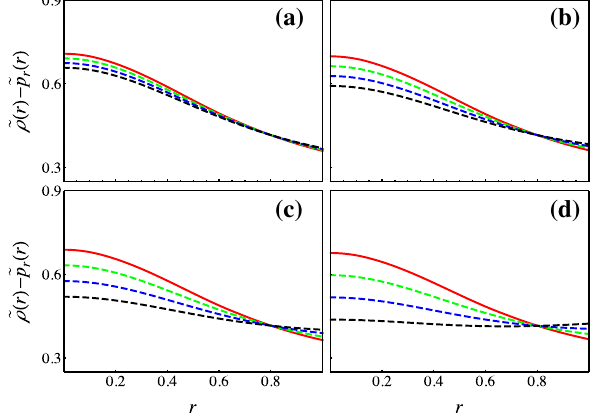
Fig. 3 Effective tangential pressure ˜ p t for M = 0 . 2, R = 1, c 1 = 0 . 5 and a C = − 0 . 1, b C = − 0 . 2, c C = − 0 . 3, d C = − 0 . 4. α = 0 . 1 (red line), α = 0 . 3, (green line), α = 0 . 5 (blue line), α = 0 . 7 (black line)